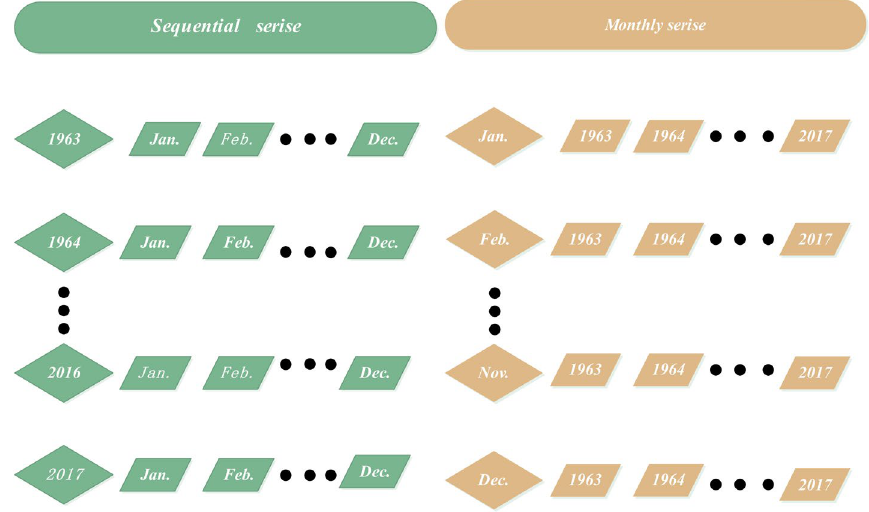
Figure 5. Data structure.